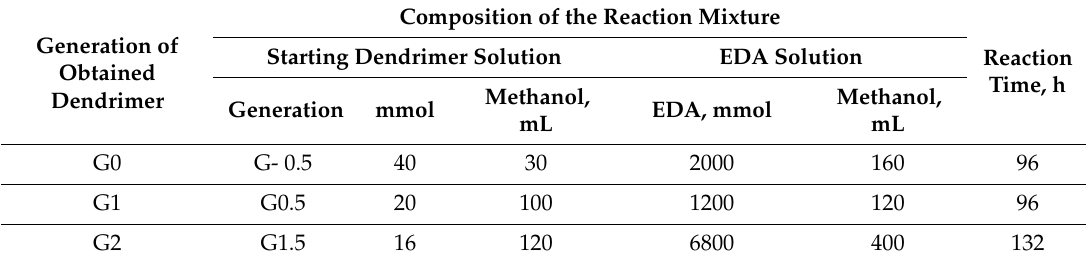
Table 2. Synthesis of amine-terminated PAMAM